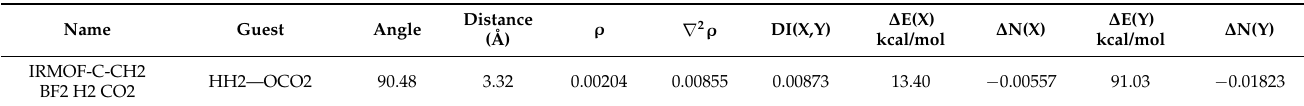
Table 15. Topological parameters of the BCP of bond in adsorption configurations of guest molecules (CO 2 and H 2 ) on IRMOF-C-CH 2 BF 2 —H 2 CO 2 . Guest intermolecular